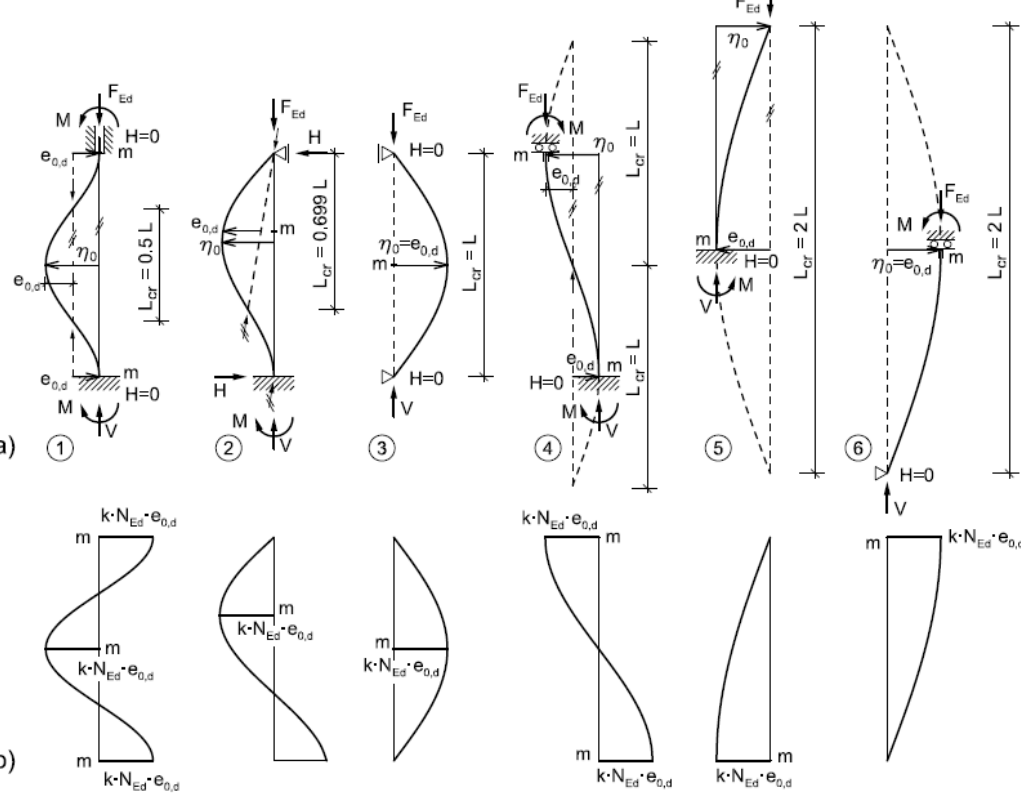
Figure 14. Geometrical interpretation of: (a) UGLI imperfection amplitude η 0 and (b) amplitude η 0,ad of the additional deformation of the member under study with length L ; (c) amplitude e 0,d of the equivalent member with length L cr = 0.699 L .